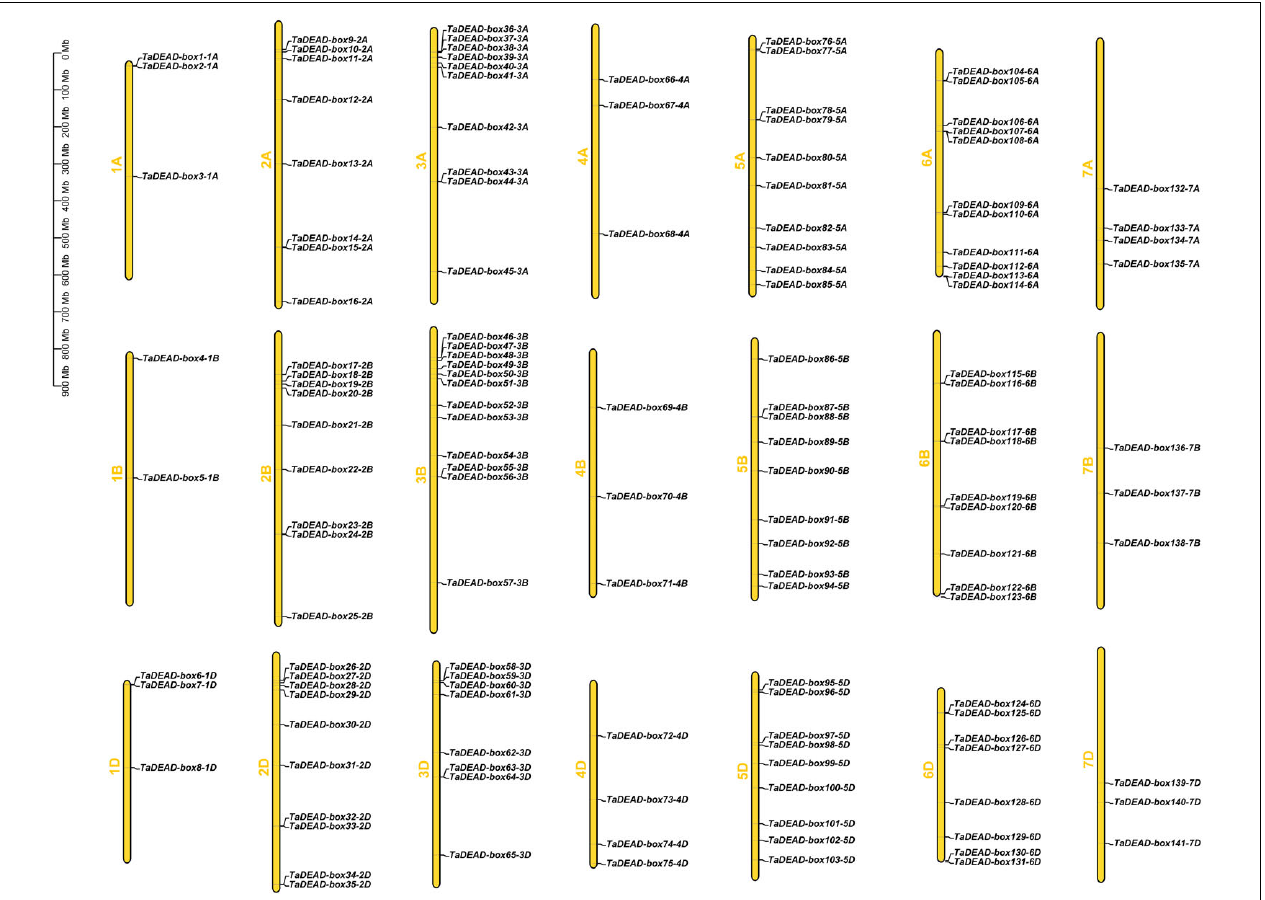
FIGURE 2 | Chromosomal distribution of the 141 TaDEAD-box genes. The 141 TaDEAD-box genes were unevenly distributed on all 21 wheat chromosomes. The chromosome numbers are denoted left of each chromosome, and the bar locates on the left side shows the size of chromosome in megabases (MB).